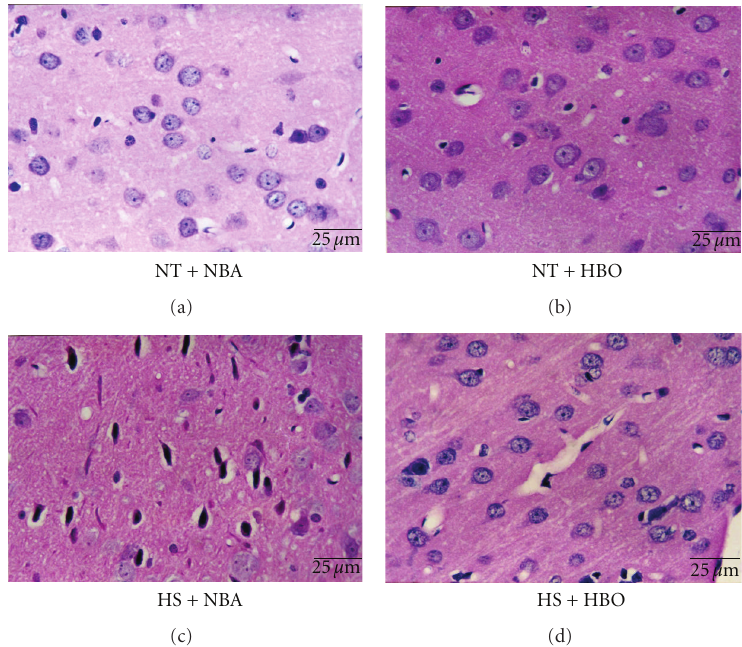
Figure 1: Photomicrographs of HE staining of the hypothalamus of normothermic (NT) mouse received normobaric air (NBA) (NT+NBA),